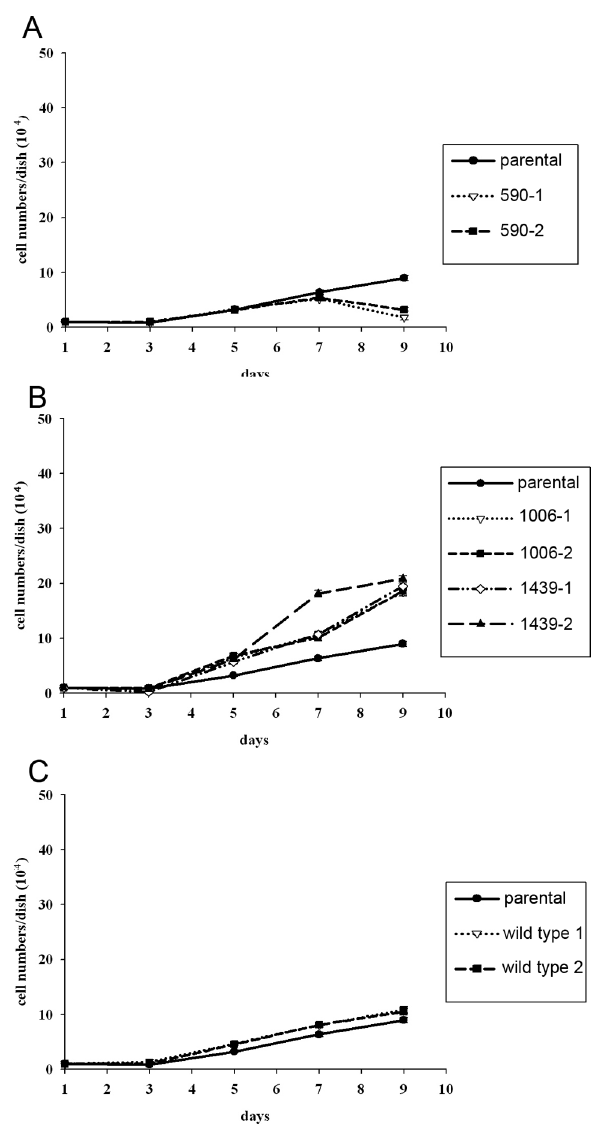
Figure 6. Growth of cells expressing mutant SWAP-70 under low serum conditions. 2 6 10 5 cells were plated onto 6-cm dishes in the medium containing 1% calf serum, and cell numbers were counted every other day. The medium was exchanged every other day. For reference, the growth curves of the parental cells are shown in every graph. The symbols for the cell lines are shown in the right-hand boxes.